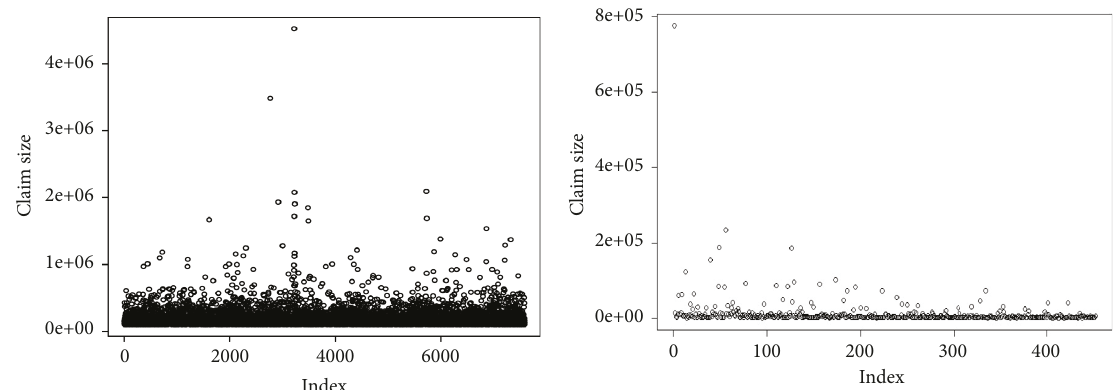
Figure 7: Scatter plots: SOA claims data (left panel); GH claims data (right panel).